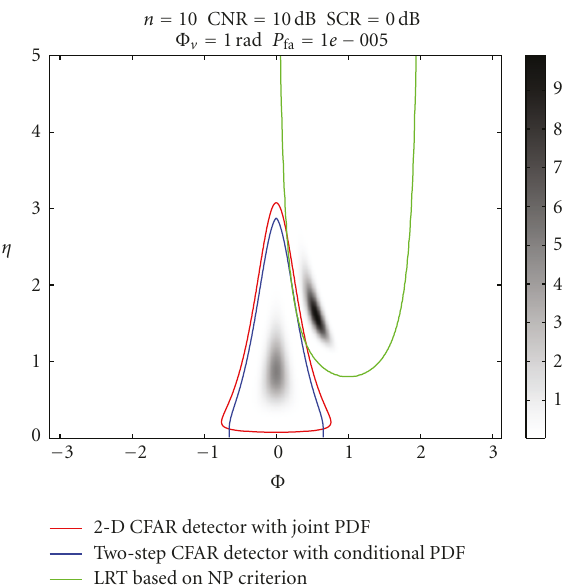
Figure 7: Joint PDF of the two hypotheses and the threshold curves of ATI detectors for n = 10, CNR = 10 dB, SCR = 0dB, P fa = 1 e − 5, Φ v = 1rad. (two-step CFAR with conditional PDF, 2D CFAR with joint PDF, and LRT based on NP criterion).